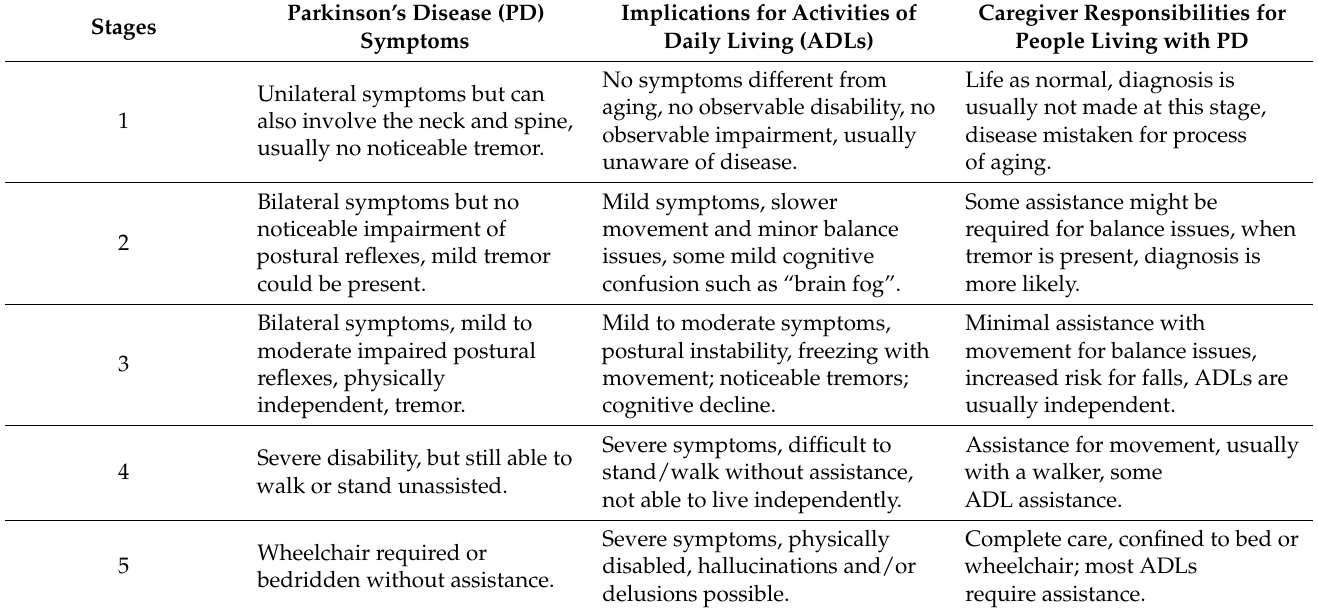
Table 1. Hoehn and Yahr